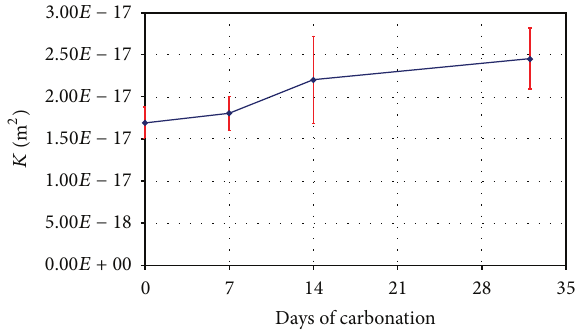
Figure 10: Evolution of the intrinsic permeability to helium during carbonation. Table 3: Coefficient of dimension 𝑘 of mortar during carbonation. Days of carbonation